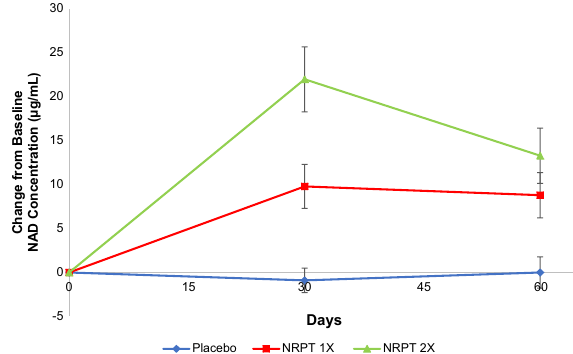
Fig. 2 NRPT increases NAD + levels. Total NAD + levels were measured in whole blood from all subjects at day 0 (baseline), day 30, and day 60. Graph depicts change from baseline NAD + concentration ( μ g/ml) for Placebo (blue diamonds), NRPT 1X (red squares) and NRPT 2X (green triangles). Data shown is the mean ± standard deviation of the mean for each time